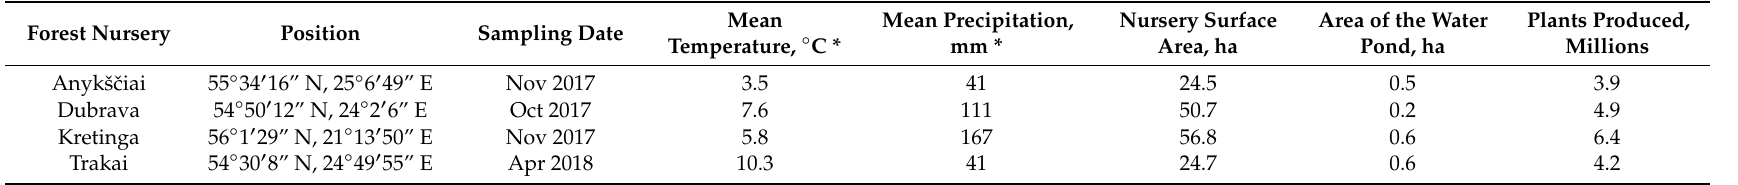
Table 1. Characteristics of the study sites and the meteorological data obtained from the nearest meteorological